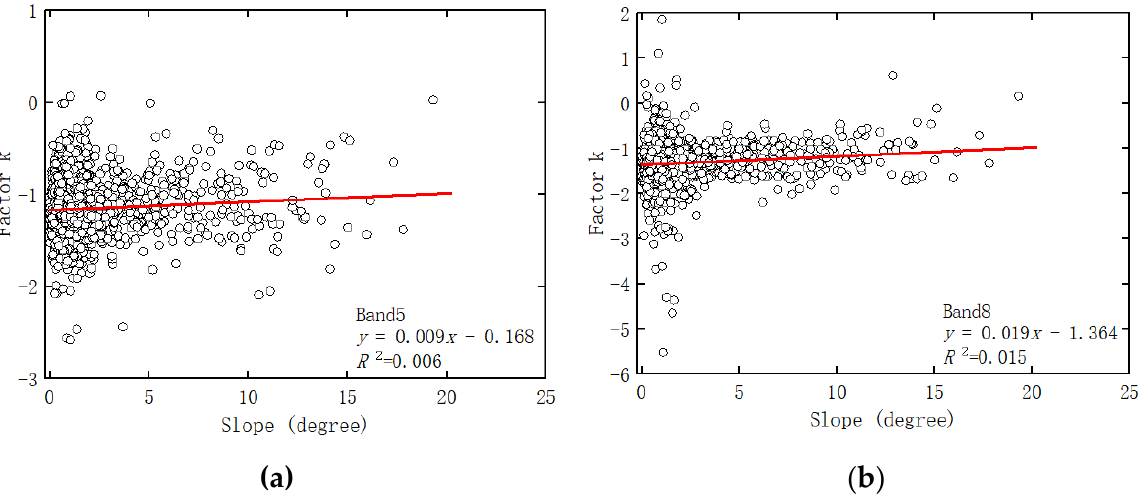
Figure 7. Density scatterplots between the slope and factor k in SANM for GOCI images band 5 ( a ) and band 8 ( b ) ground object reflectance .